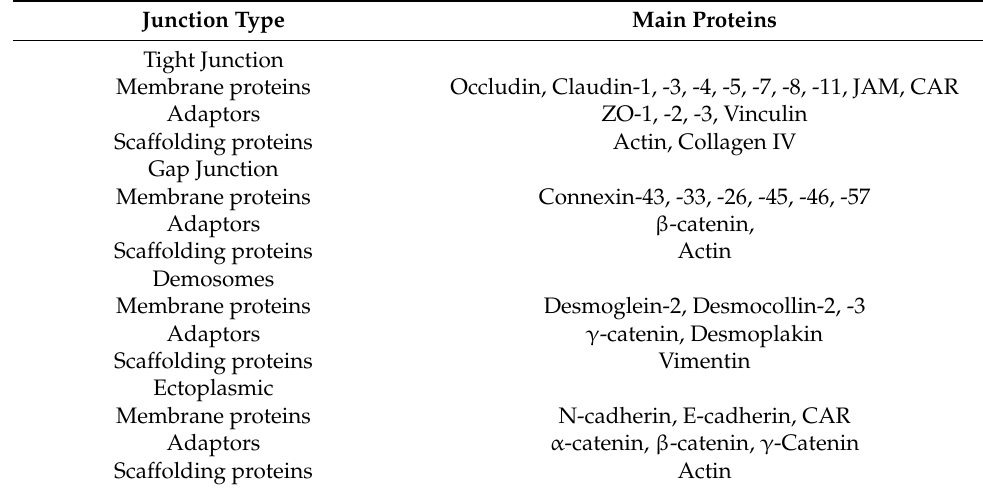
Table 1. The main proteins of blood–testis junctions in rodent